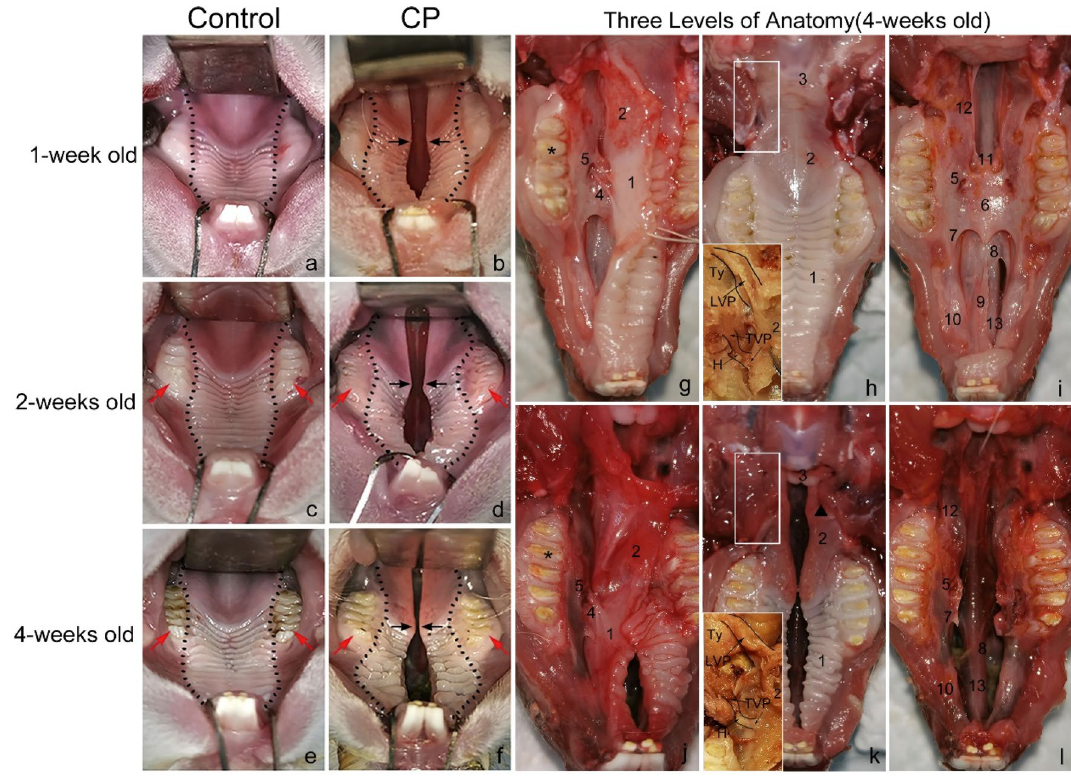
Figure 3. Occlusal views (left) of the control group ( a , c , e ) and the cleft palate group ( b , d , f ) at week 1 ( a , b ), 2 ( c , d ), and 4 ( e , f ). The dotted line represents the U-shaped palate contour in the control group and the hourglass-shaped palate in the cleft palate group. The black arrow indicates that the gap gradually narrowed at the junction of the hard and soft palate, but widened at the front of the hard palate. Notice that premolars and molars in the cleft showed slow eruption and dental dysplasia compared with those in the control (red arrow). Regional anatomic comparisons (right) of the control group ( g , h , i ) and the cleft palate group ( j , k , l ) at week 4. Three levels of anatomy: Parapharyngeal and soft palate mucosa and muscles after removing the mandible ( h , k ); Lateral sub-mucoperiosteal tissue surrounding the alveolar ( g , j ); Bony structure along the midline of the maxilla ( i , l ). Asterisk: the first molar. Black triangle: strip-shaped muscle at the margin of the crack. C control, CP cleft palate, TVP tensor veli palatini muscle, originating from the lateral surface of the pterygoid plate and turning around a curved process, LVP levator veli palatini muscle, arising from the lateral and posterior surface of tympanic bulla. H pterygoid hamulus, Ty tympanic bulla. 1—Hard palate, 2—soft palate, 3—epiglottic cartilage, 4—anterior palatine nerve, and blood vessel, 5—foramina palatina majora, 6—palatine bone plate, 7—palatine process of maxilla, 8—vomeronasal organ, 9—incisor bone, 10—premaxillary, 11—ala of the vomer, 12—pterygoid plate of the sphenoid bone, 13—nasal